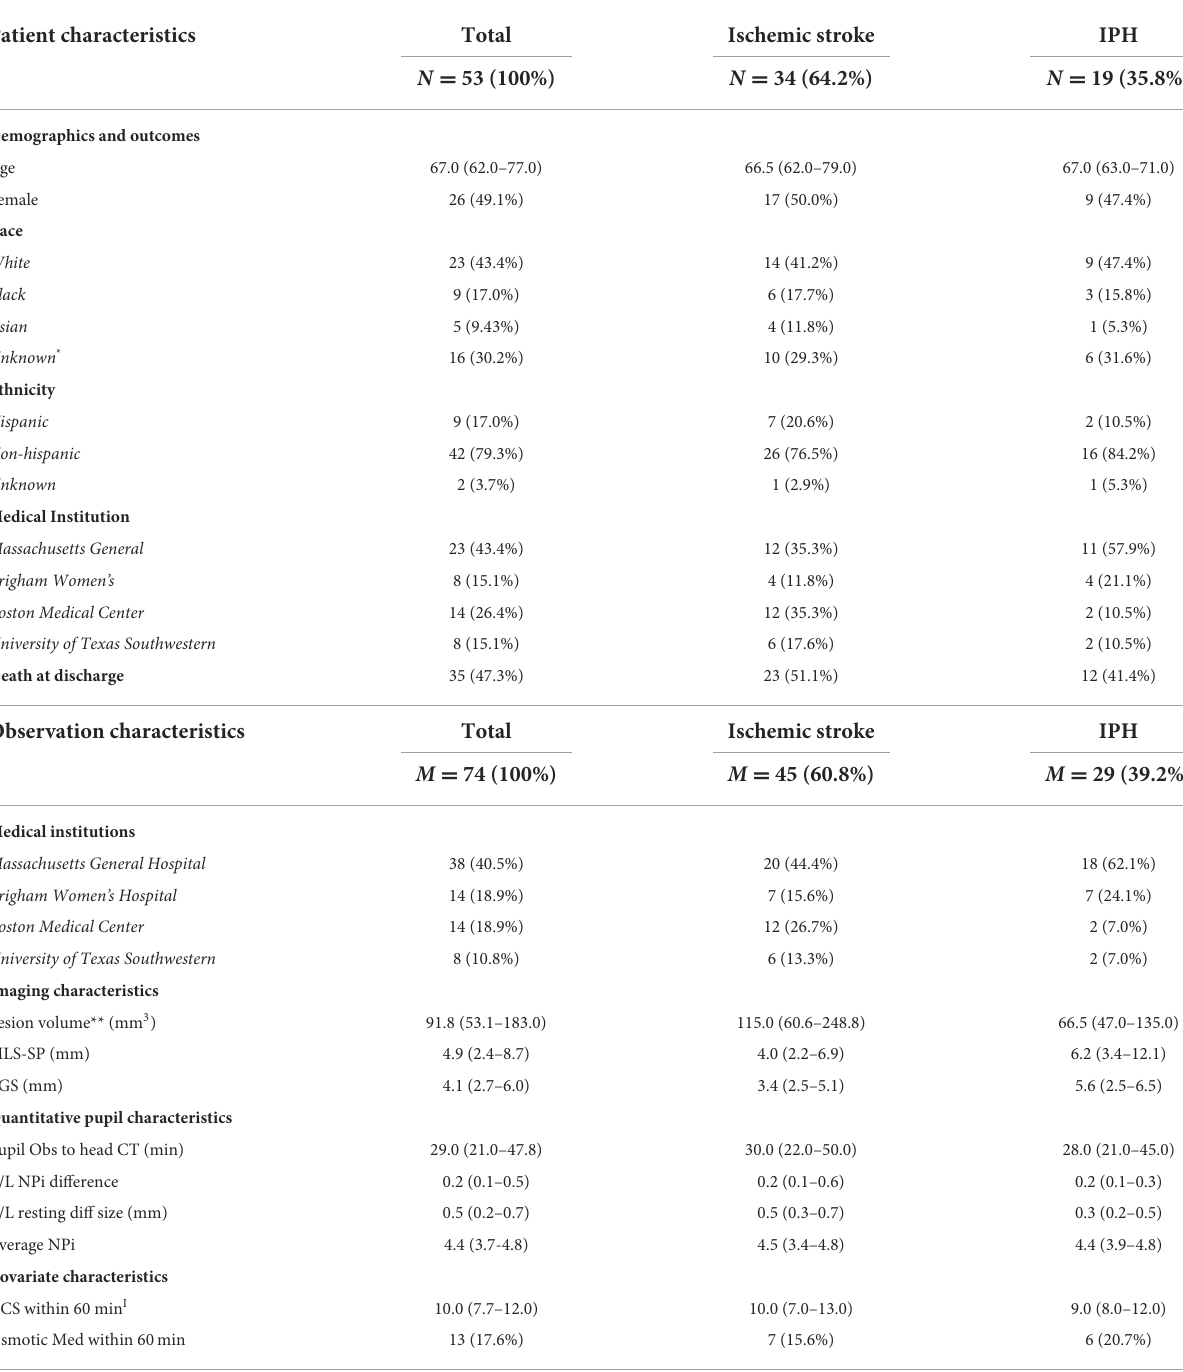
TABLE 1 Baseline patient and observation